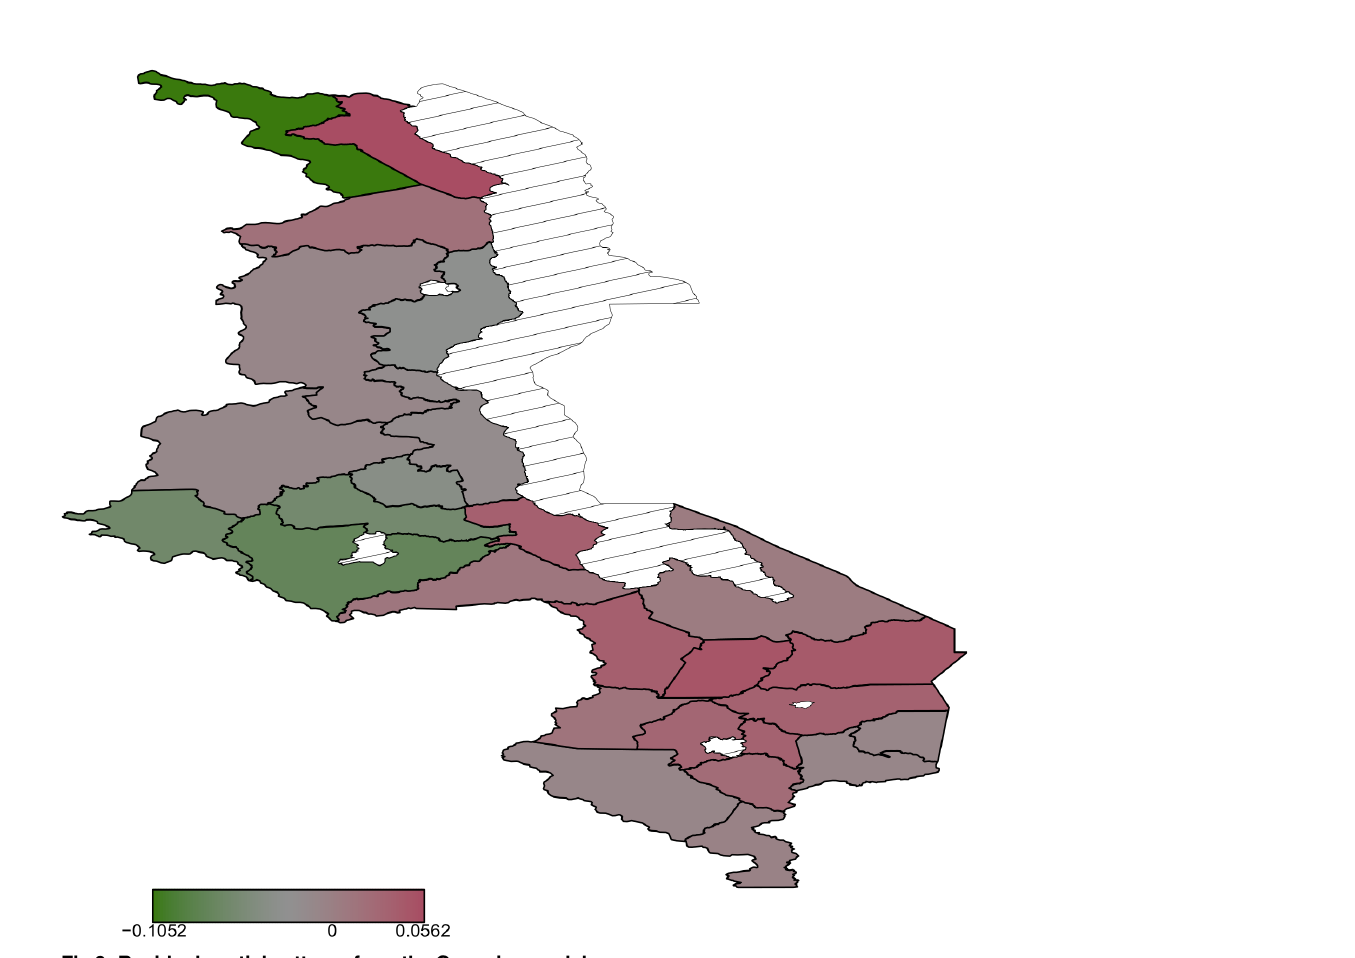
Fig 3. Residual spatial patterns from the Gaussian model